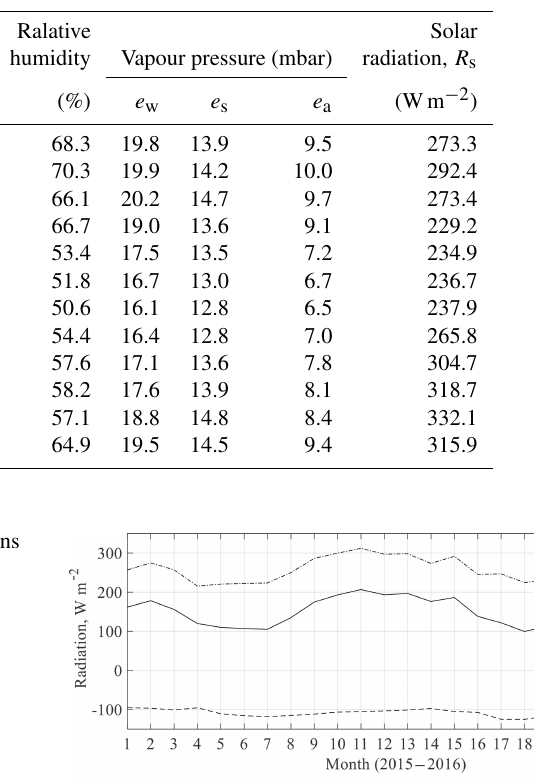
Table 3. Monthly averages of main climatic variables observed during the 2015–2016 period.